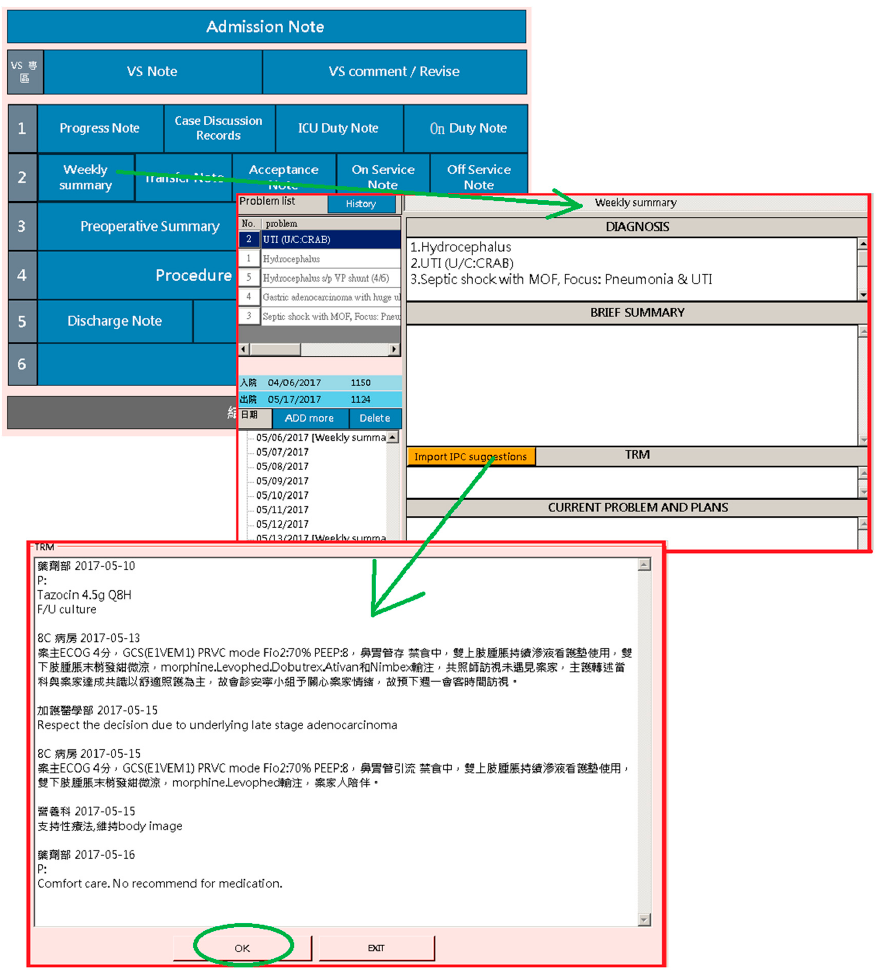
Figure 6. Weekly summary of a patient’s medical care records.